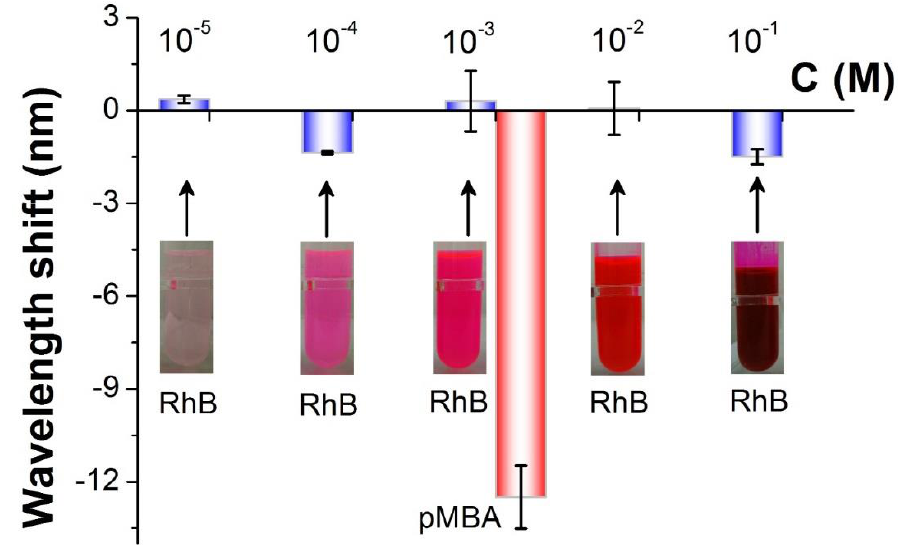
Figure 6. The response of the VIOLIN to different RhB ethanol solutions in comparison with the response to the moderate concentration of p MBA. “C” referred to “concentration”.